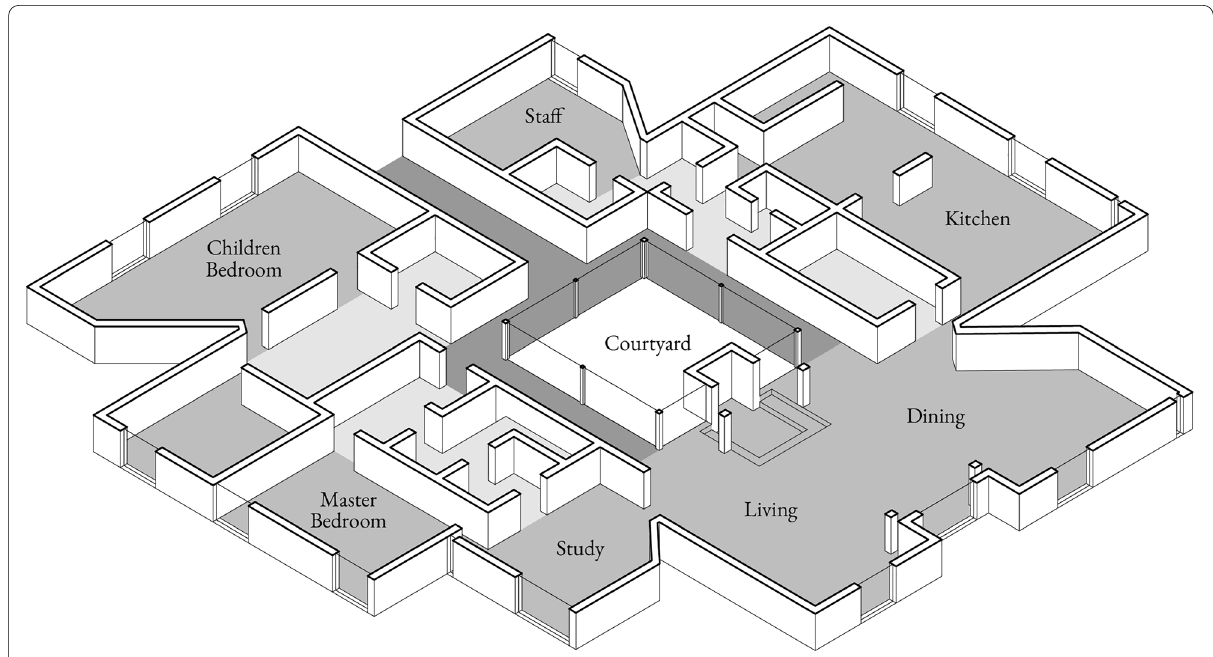
Fig. 1 Goldenberg House , L. I. Kahn, 1959 (unbuilt). Dark gray: connections, medium gray: served space, light gray: servant